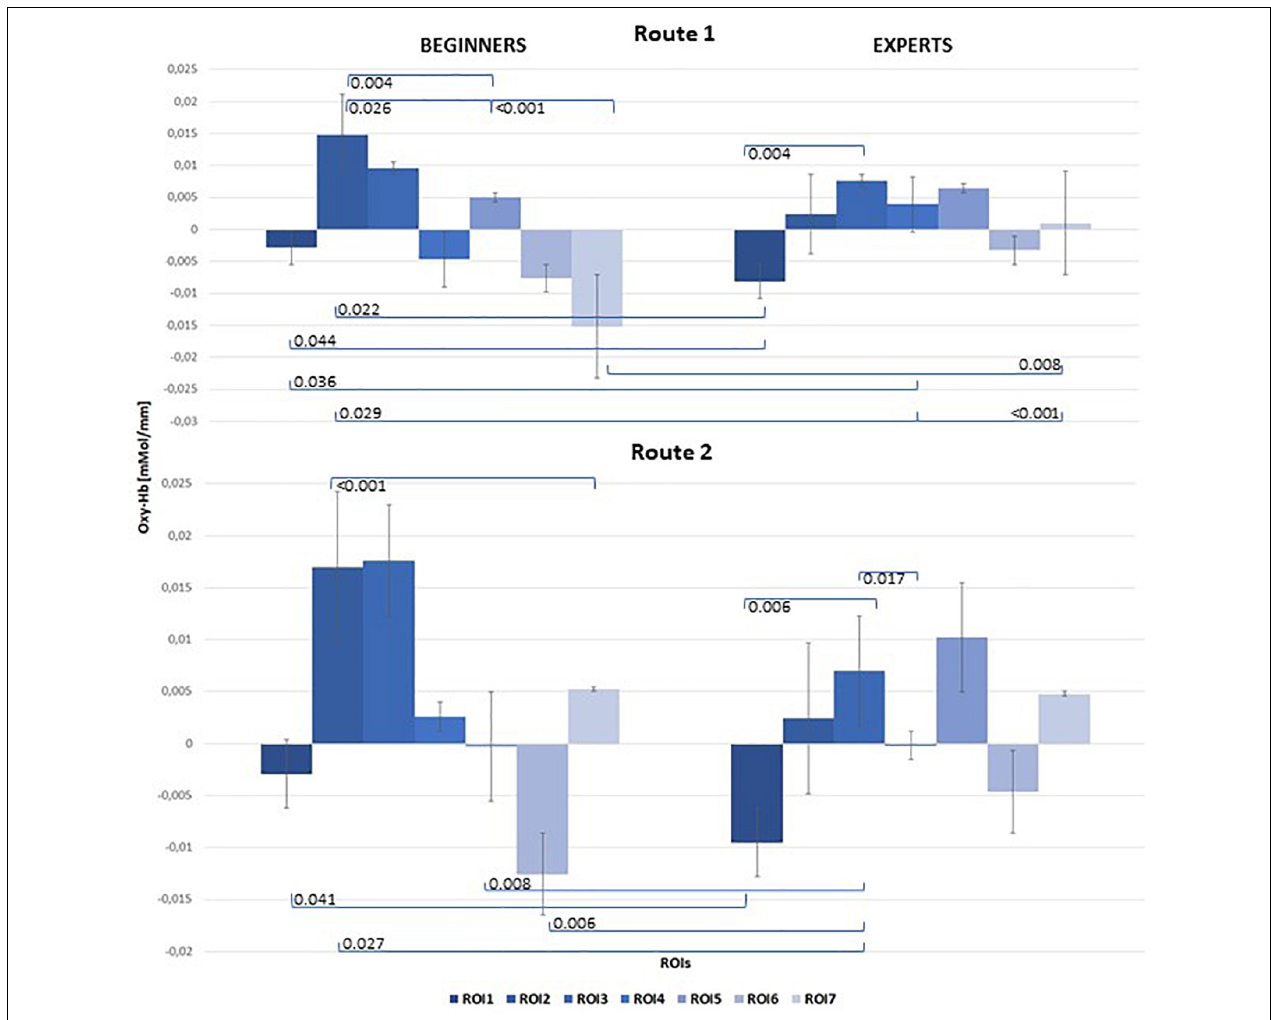
FIGURE 5 | Bar chart of mean [oxy-Hb] concentration changes for both groups (left: Beginners; right: Experts), all 7 ROIs and both Routes: top level: Route 1 = easy; bottom level: Route 2 = difficult. Significant results of post hoc comparisons between beginners and experts were indicated with Tukey-test corrected p -values ( α =